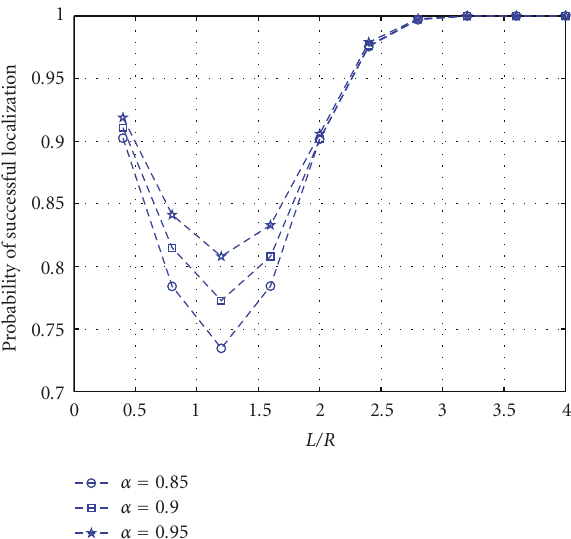
Figure 10: The e ff ect of α on basic TSCD